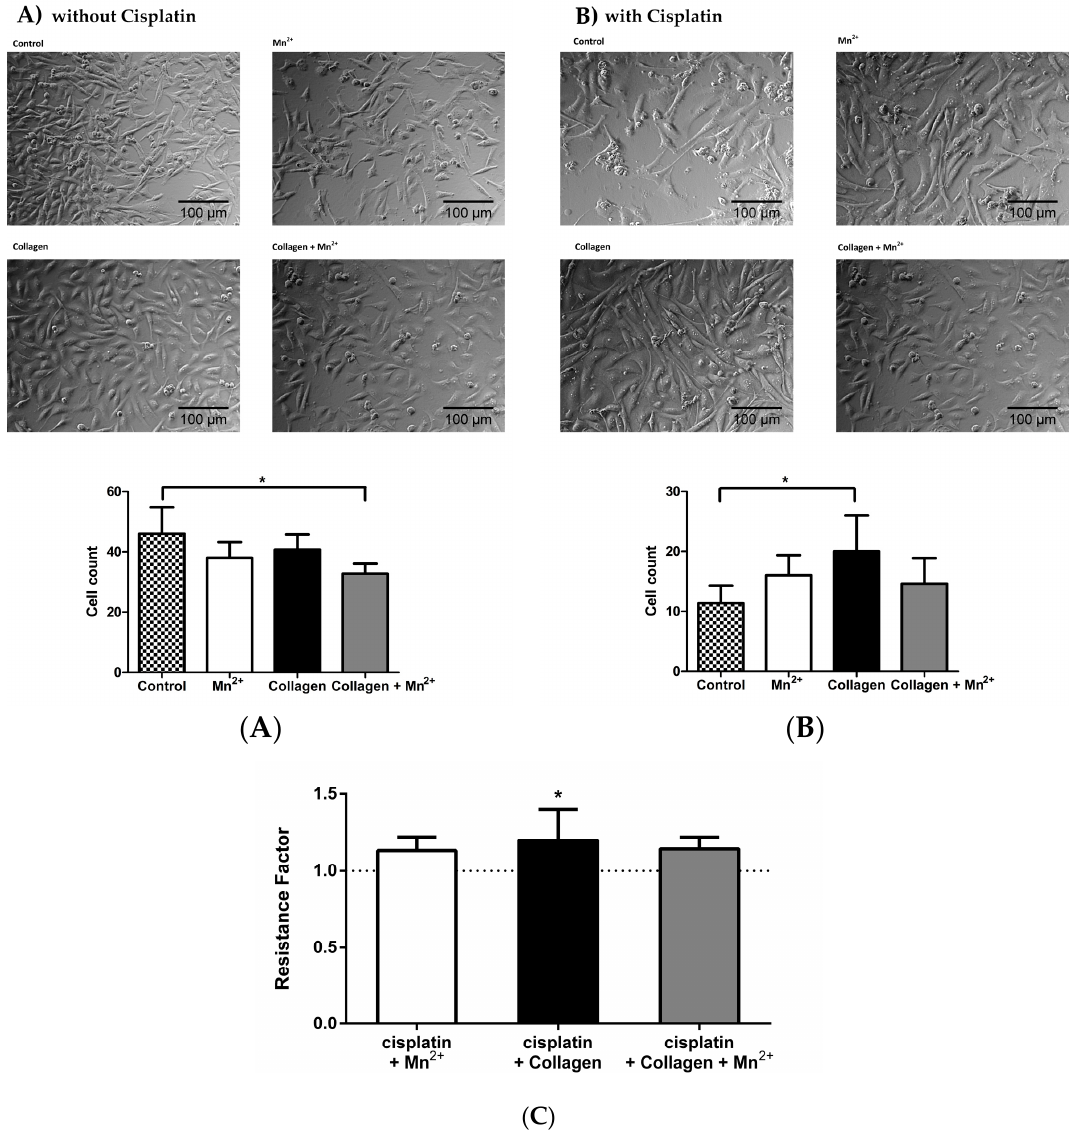
Figure 1. ( A ) Exemplary microscopy images of MV3 cells, cultured for 72 h, under the indicated conditions (control, collagen or/and manganese) without cisplatin. ( B) Exemplary microscopic pictures of MV3 cells, cultured for 72 h, under the same indicated conditions, but in the presence of cisplatin (7.5 μ M). Pictures were taken at five different growth spots (for all treatments) and cells were then counted in a predefined area. The graph displays the mean of cells counted for the different spots ( n = 5), which were then analysed by one-way ANOVA. Asterisks indicate statistical significance: * p < 0.05; ** p < 0.01; *** p < 0.001. ( C ) Resistance factors (ratio between IC 50 of treated vs. control) of MV3 cells as indicator for sensitivity to cisplatin cytotoxicity.